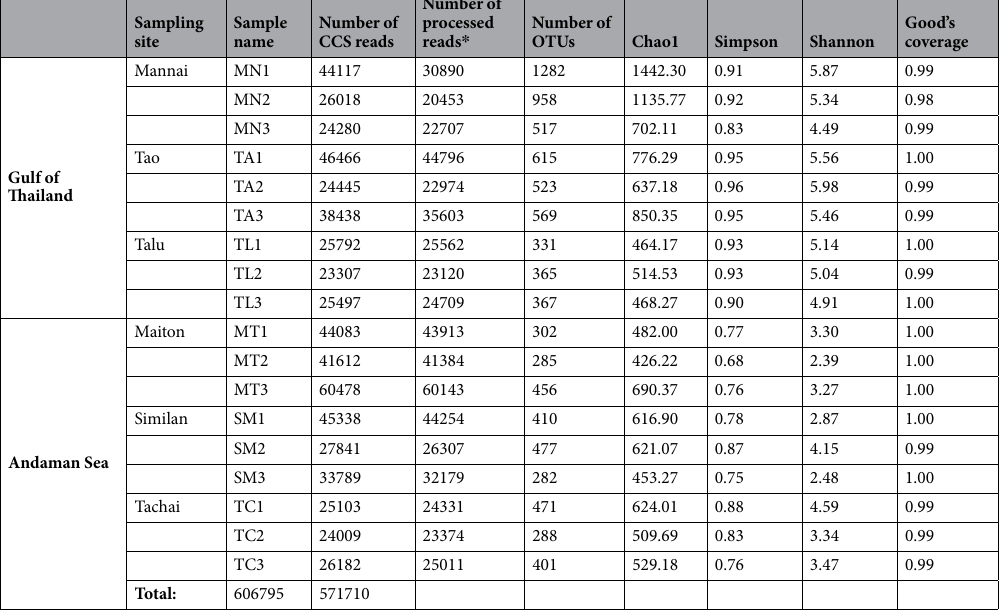
Table 1. Number of sequences, OTUs and alpha diversity estimates of bacterial communities associated with P. lutea in the Gulf of Thailand and Andaman Sea. * After the removal of chimeras and reads shorter than 1000